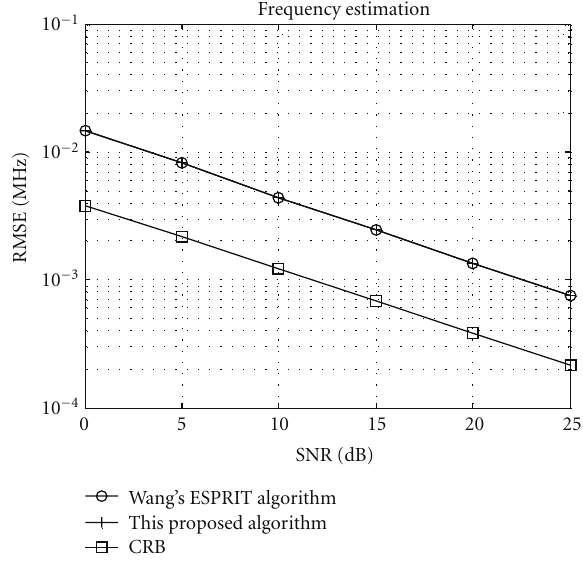
Figure 4: Frequency estimation performance comparison at M = 12, K = 3, P = 3, and N = 100.